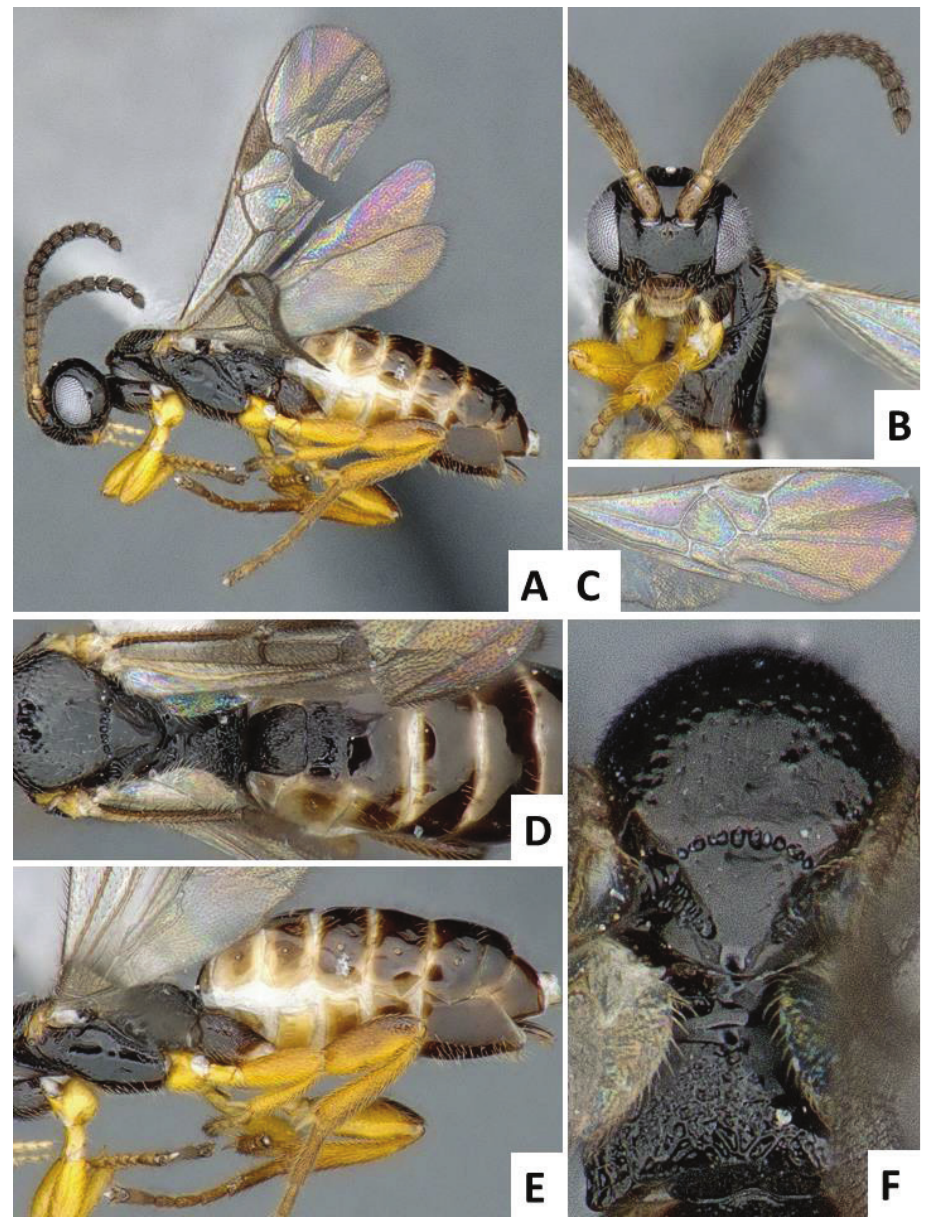
Figure 6. Cotesia sesamiae , female specimen from Mombasa, Kenya. A Habitus, lateral view B Head, frontal view C Wings D Mesosoma and metasoma (partially), dorsal view E Mesosoma and metasoma, lateral view F Anteromesoscutum, scutellar disc and propodeum, dorsal